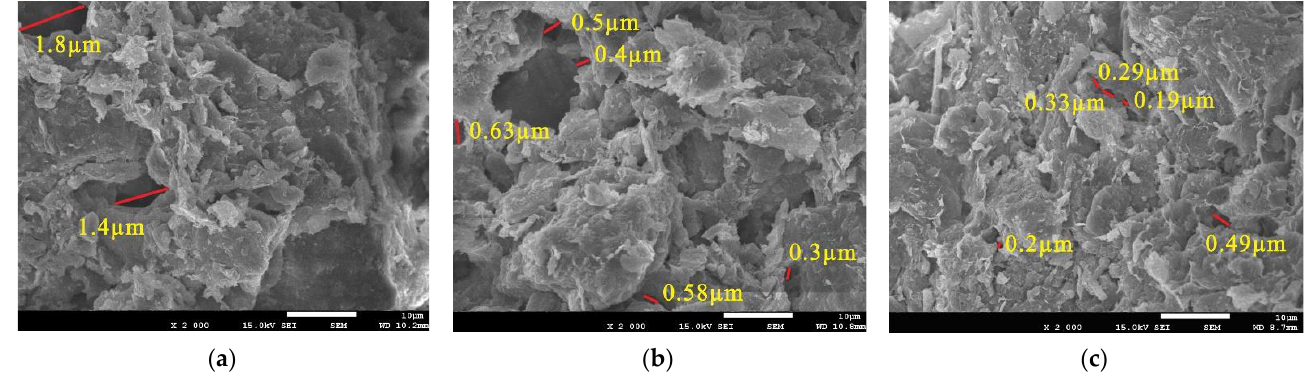
Figure 9. SEM pictures of XG-silt at ×2000 magnification: ( a ) m bp / m s = 0%; ( b ) m bp / m s = 1.0%; ( c ) m bp / m s = 2.0%.